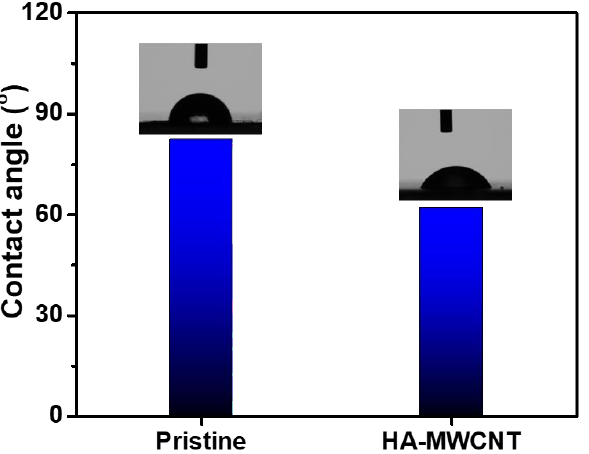
Figure 7. Water contact angle on the pristine and the HA-MWCNT membrane.